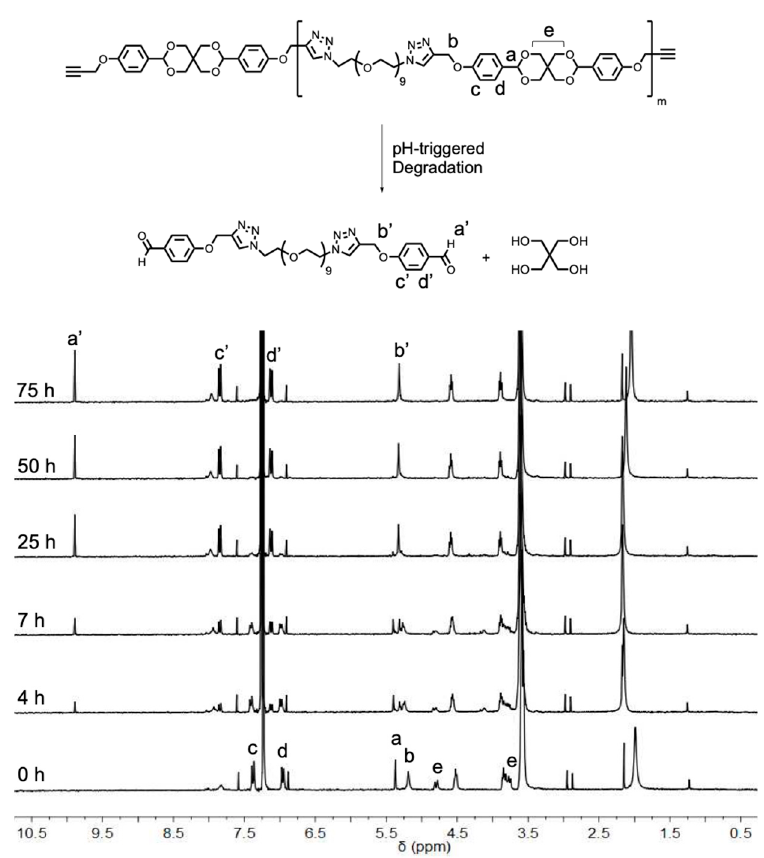
Figure 2. A pH-triggered degradation reaction of 7 in acidic media ( top ) monitored by 1 H NMR spectroscopy ( bottom ).